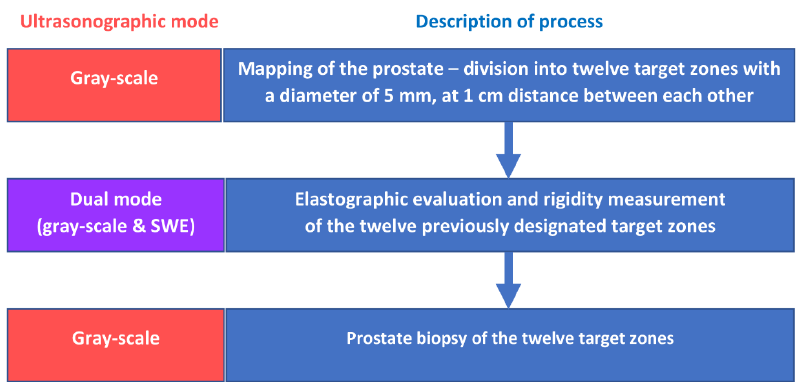
Figure 3. Scheme of the image processing and systematic biopsy of the twelve target areas.